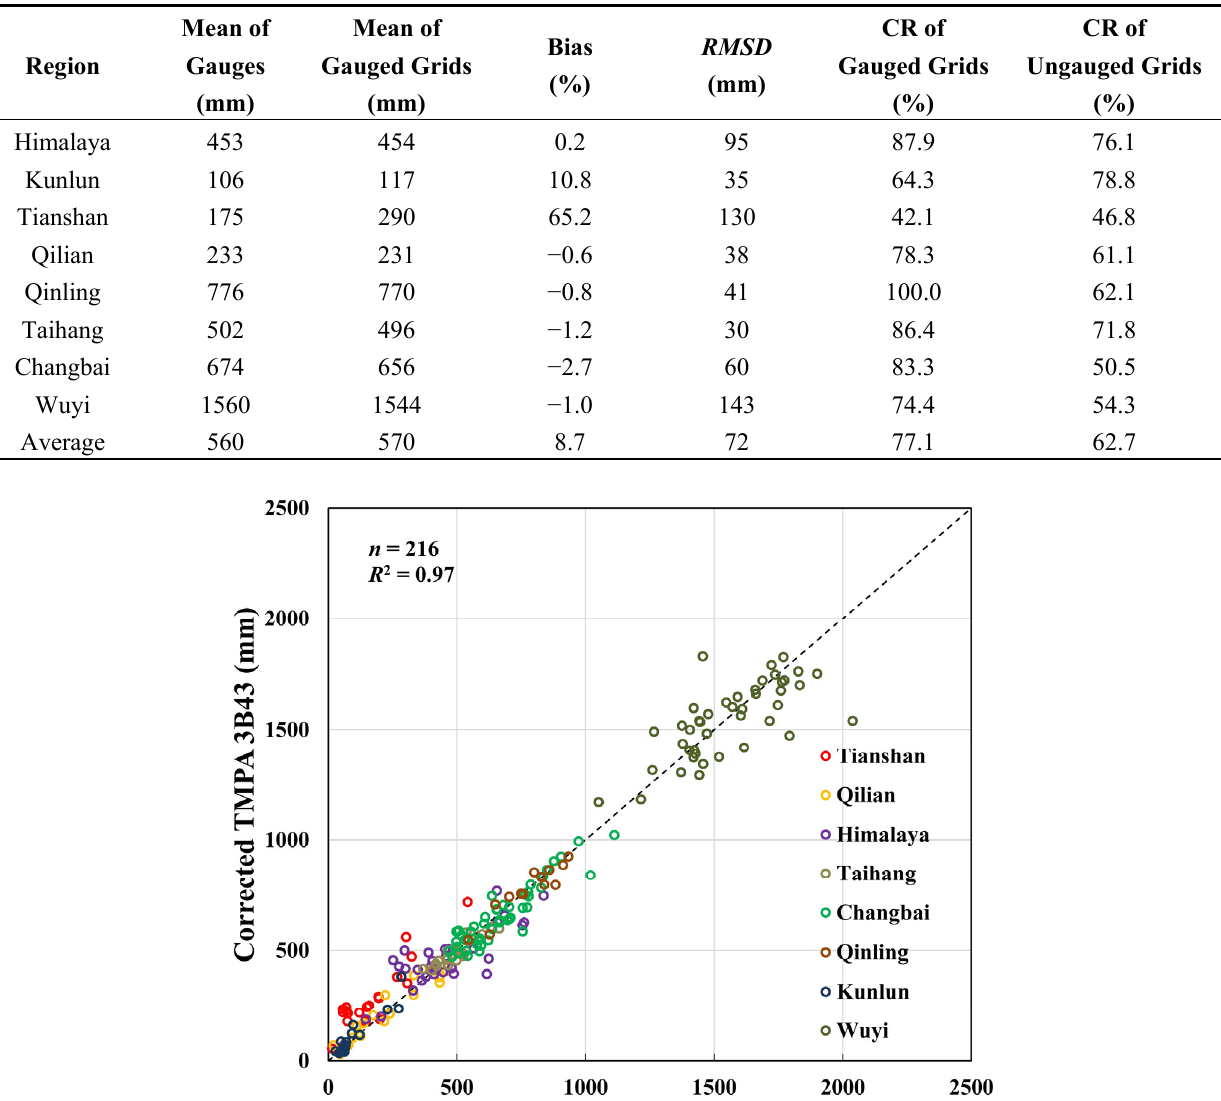
Table 8. Comparison of mean annual rainfall (2001–2012) from gauge measurements and corrected 3B42RT.